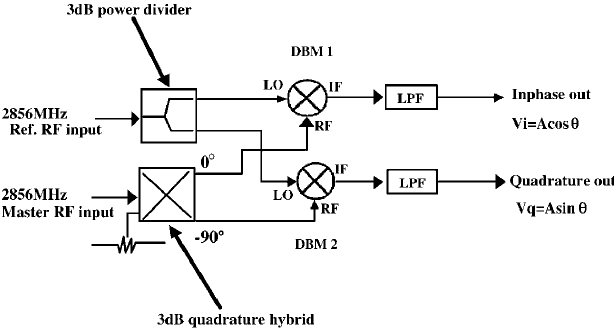
FIG. 4. Block diagram of the fast phase detector (I/Q detector).